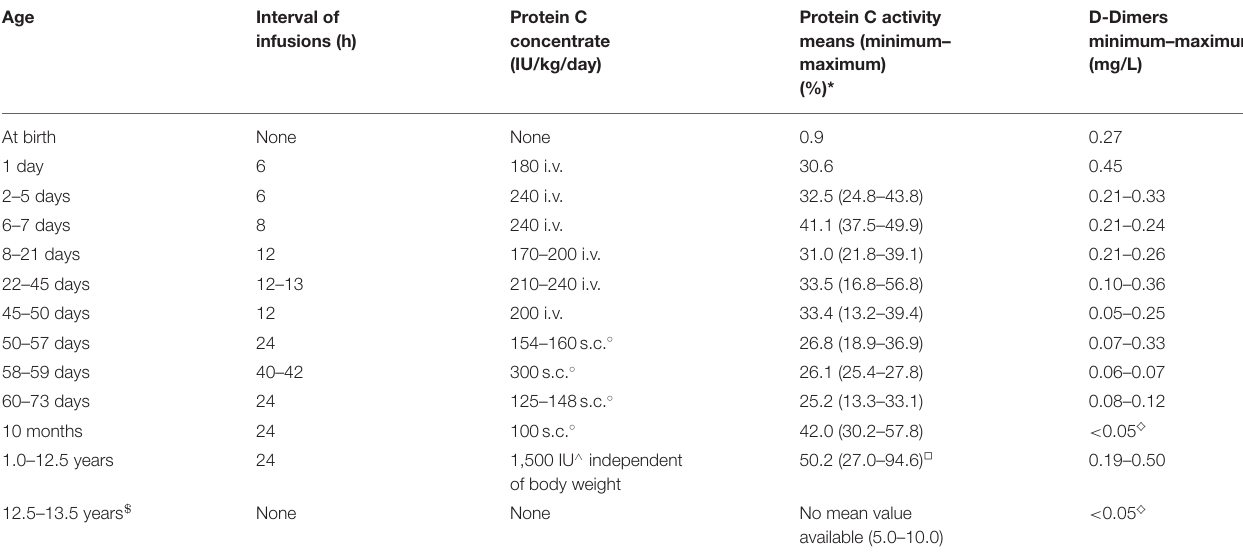
TABLE 2 | Course of